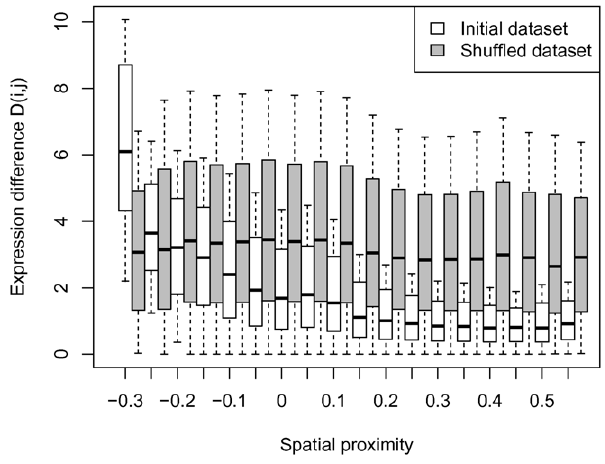
Figure 5. Correlation of the spatial proximity values with COXPRESdb co-expression values. Whisker boxes are as in Fig. 1.